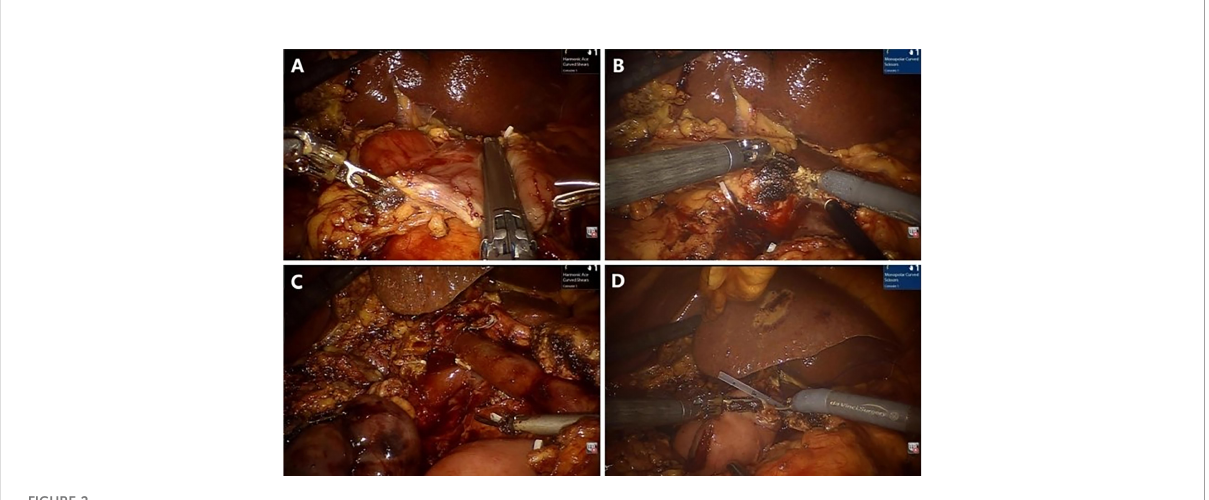
FIGURE 2 Representative photographs of the RPD: (A) Transection of the stomach. (B) Transection of the pancreas. (C) Complete resection. (D) Pancreaticojejunostomy